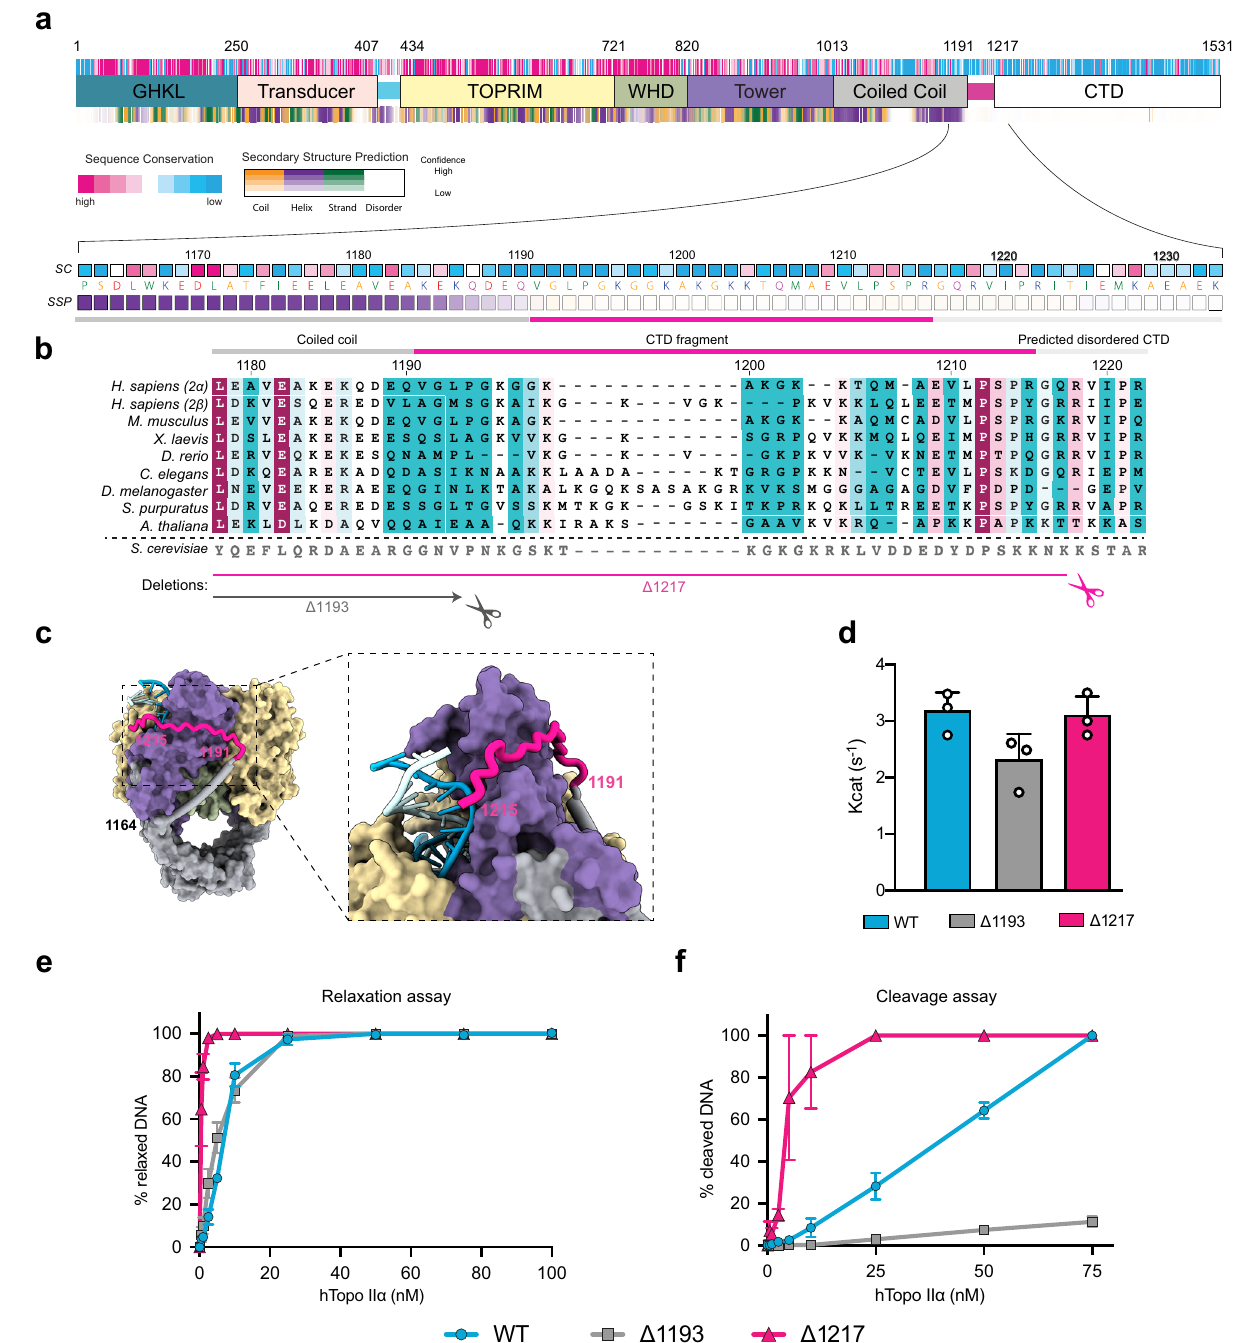
Fig. 5 Regulation of the catalytic activity by the C-terminal domain linker. a Domain organization, sequence conservation, and secondary structure prediction for hTopo II α . Below is a zoom view of the CTD fragment visible in the EM reconstruction showing the sequence at a residue level. SC stands for sequence conservation. SSP stands for secondary structure prediction. b Multiple sequence alignment focused on the CTD linker region. The yeast sequence is displayed as information but was not included in the conservation calculation. The CTD deletions are shown below. c Orthogonal views of the DNA-binding/cleavage domain in closed state. The CTD domain is highlighted in pink. The inset shows a zoom on the region of the CTD which comes in close vicinity of the DNA G-segment. d ATP hydrolysis activity by wild-type, Δ 1193 and Δ 1217 hTopo II α . Kcat values are presented as mean values ± SE for three independent replicates ( n = 3). Individual data points are also plotted. e Relaxation and cleavage f activities for the wild-type, Δ 1193 and Δ 1217 hTopo II α . Zoomed panels on the region 0 – 10 nM is available in Supplementary Fig. 9. Data are presented as mean values ± SE for three independent replicates ( n = 3). The source data for panels d – f are provided as a Source Data fi